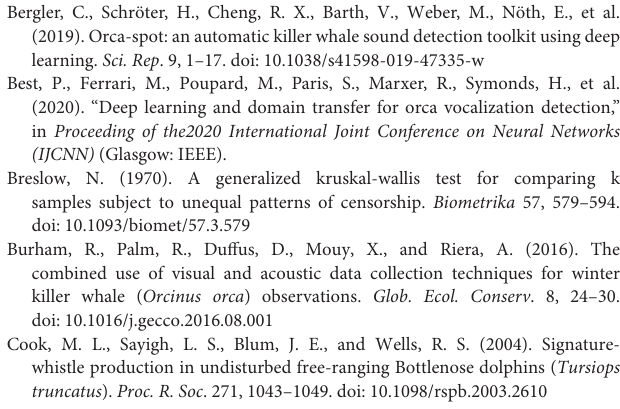
Supplementary Figure 1 | The frequency response of the hydrophone SQ26. Supplementary Figure 2 | The JASON CARD. Supplementary Figure 3 | The range map of the antenna. Supplementary Figure 4 | An example of annotation. Supplementary Figure 5 | The list of all